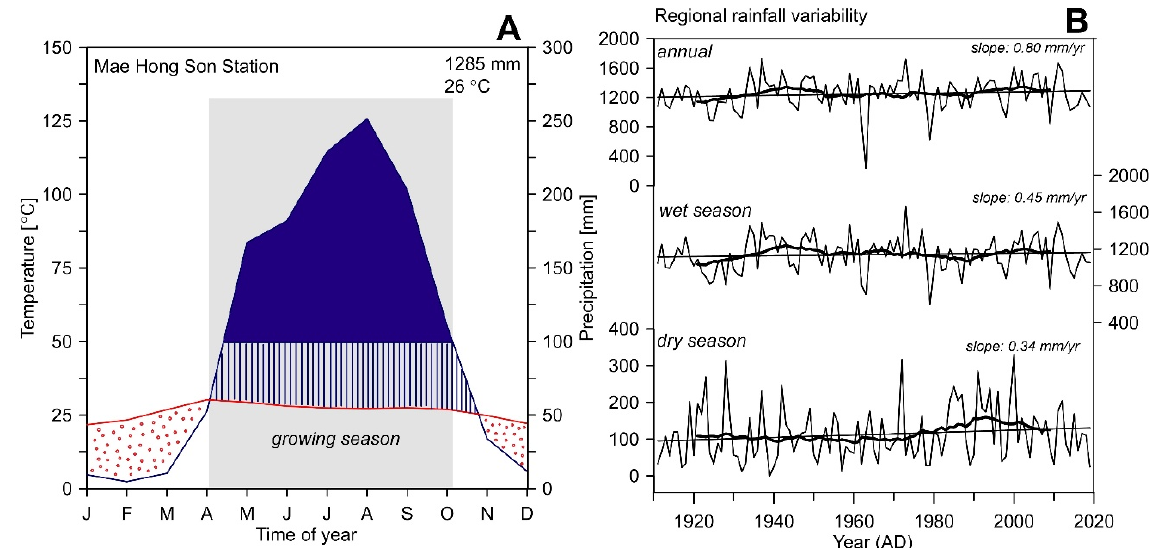
Figure 2. ( A ) Walter and Lieth climate diagram (Walter and Lieth, 1967) monthly rainfall totals and mean temperatures between AD 1951 and 2019 for the MHS (Thai Meteorological Department, 2019). The dark ‐ blue area and blue lines represent rainfall and temperatures, respectively. Values on the left axis of the diagrams are average maximum and minimum temperatures of the warmest and the coldest months, respectively, whereas values on the upper right corner show annual average temperature and total precipitation. Areas shaded in black and gray indicate the moist and the arid periods. The growing season (grey shadow) of teak extends approximately from April to October. ( B ) MHS rainfall for the rainy season (May to October), and dry season (November to April), and annual sum (1951–2019), 20 ‐ year cubic ‐ smoothing splines (thick black line) and linear trends lines (black line) show long ‐ term fluctuations and trends.